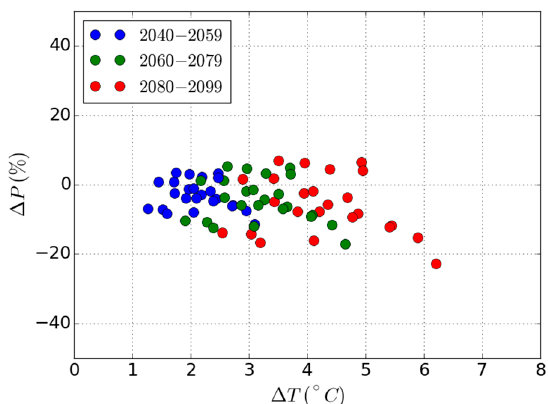
Figure 4. Scatter plot of changes in mean annual precipitation and temperature expected between a control period (1992–2010) and three future periods (i.e., 2040–2059; 2060–2079; 2080–2099) for 25 CMIP5 GCM experiments.